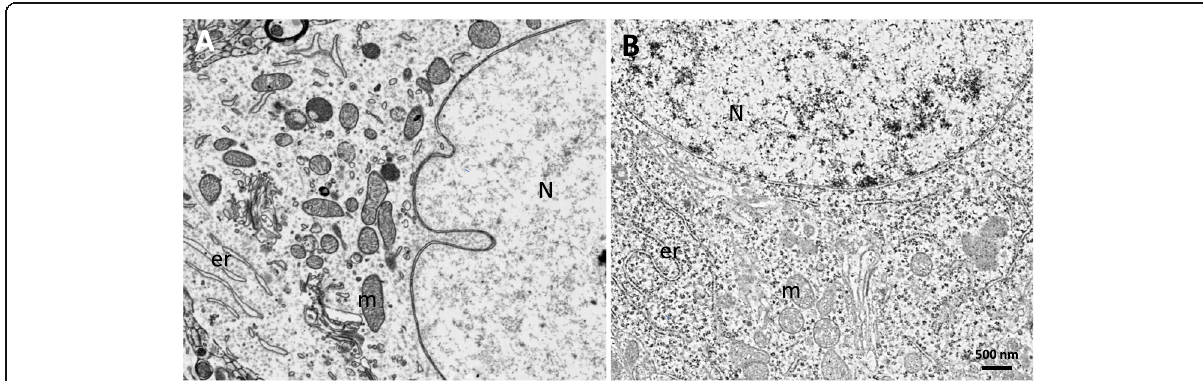
Fig. 5 Direct comparison between rOTO sample and conventional sample with double staining in SEM. a 70 nm thickness section from rOTO sample. b 70 nm thickness section from conventional block with double staining. Both images showed good contrast to investigate cellular